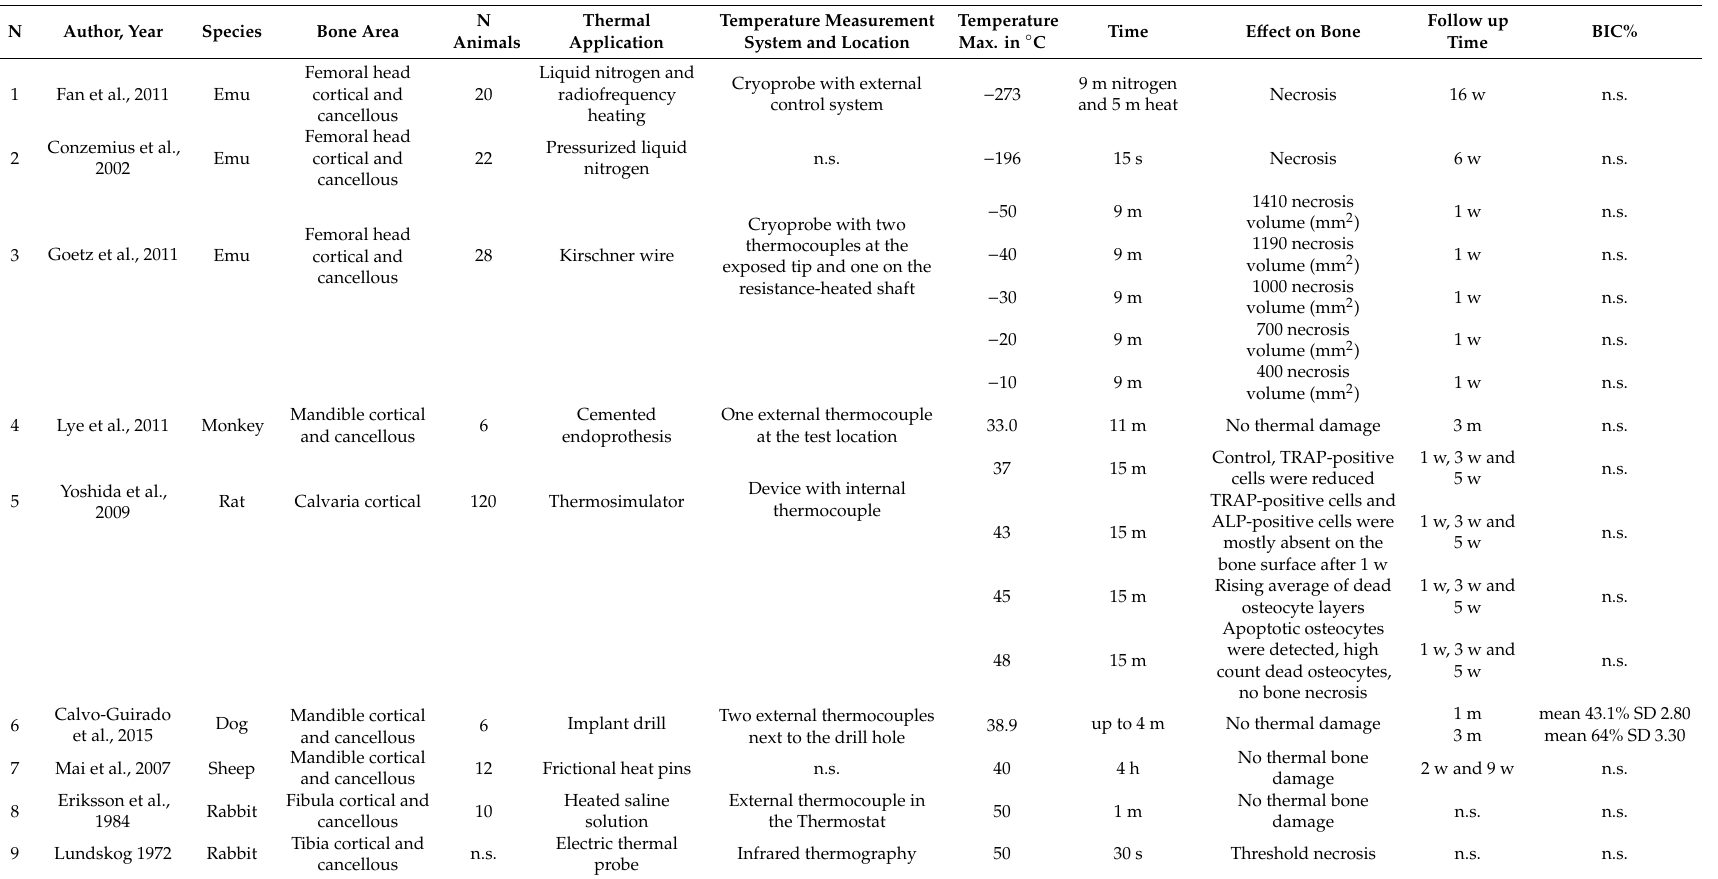
Table 2. Included animal studies evaluating temperature parameters of –273 ◦ C to 50 ◦ C on bone damage (BIC = bone-to-implant contact ratio, n.s. = not